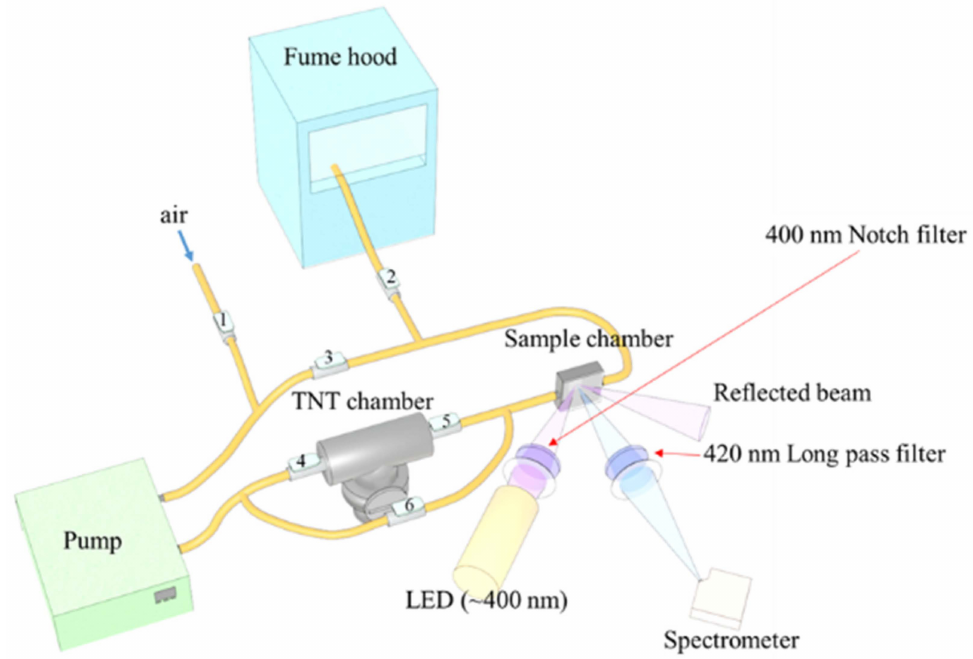
Figure 1. Experimental set-up. A closed flow cycle system was used to maintain a constant vapor pressure and to ensure personnel